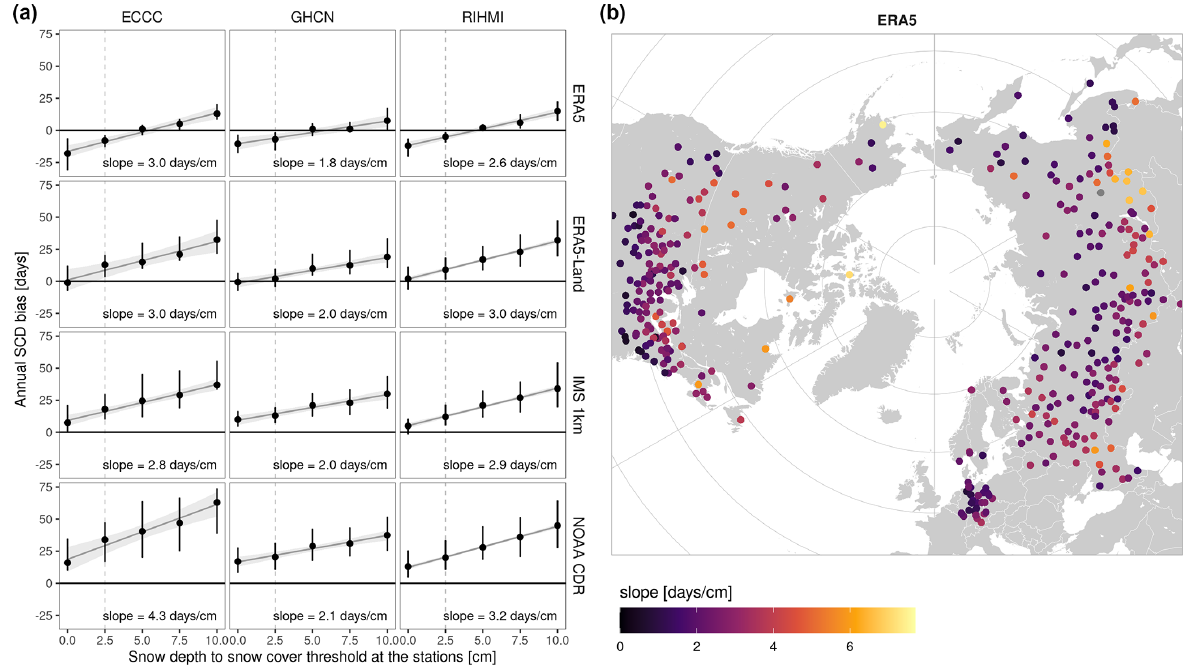
Figure A2. Sensitivity of the snow cover duration (SCD) bias on the snow depth to snow cover threshold used at the stations. ( a ) Variation of the SCD bias (median ± interquartile range) per product and network when changing the threshold from 0 to 10cm by intervals of 2.5cm. ( b ) Spatial analysis of the rate of change [dcm − 1 ] for ERA5. Both figures are derived with data from 2015.